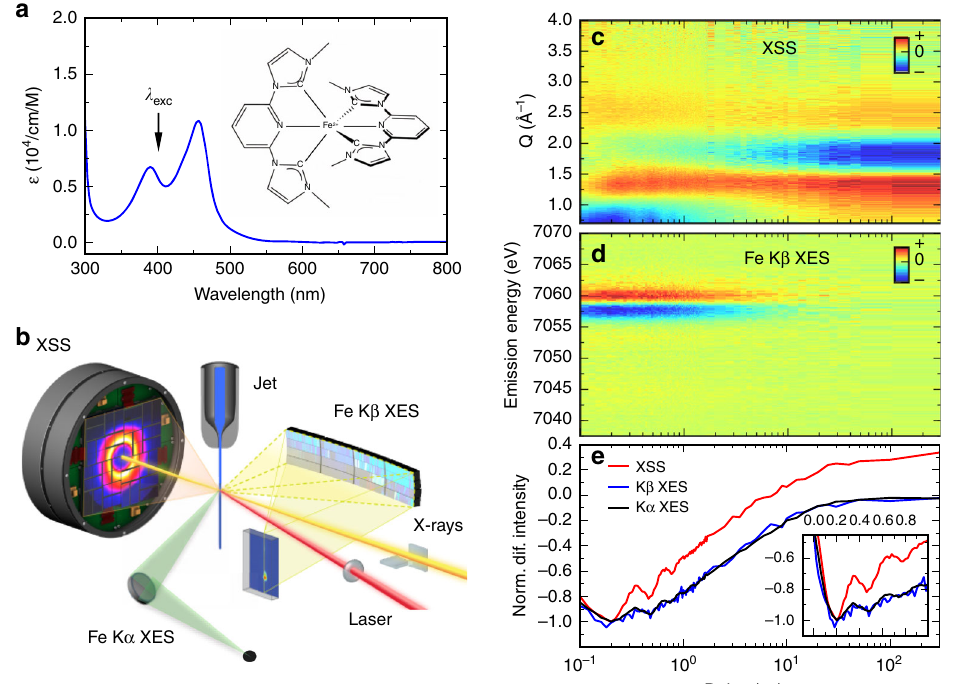
Fig. 1 Simultaneous tracking of femtosecond dynamics with X-ray scattering and emission. a UV – visible absorption spectrum of [Fe(bmip) 2 ] 2 + in acetonitrile ( ε — molar absorptivity) and its chemical structure (inset). λ exc indicates the excitation wavelength at 400 nm. b Schematic of the experimental setup, adapted from ref. 27 with permission from the Royal Society of Chemistry. A jet of the sample solution (blue) is excited with 400 nm laser light (red) and followed by 8.5 keV X-ray probe beam (yellow). XSS is collected with a large area detector downstream, whereas K α /K β XES are detected with two spectrometers positioned close to a 90° scattering geometry. c Time-resolved difference signals of XSS ( Q — length of the scattering vector), d Time- resolved difference Fe K β XES spectra. e Time-resolved Fe K α /K β XES and XSS traces (black: K α at 6404.3eV; blue: K β between 7056 and 7058.5 eV; red: XSS between 0.7 and 1.0 Å − 1 ). Inset highlights the oscillatory component of the XES and XSS signals. Difference traces normalized to − 1 at the minimum (K β scaled to maximize overlap with K α ). Source data are provided as a Source Data fi